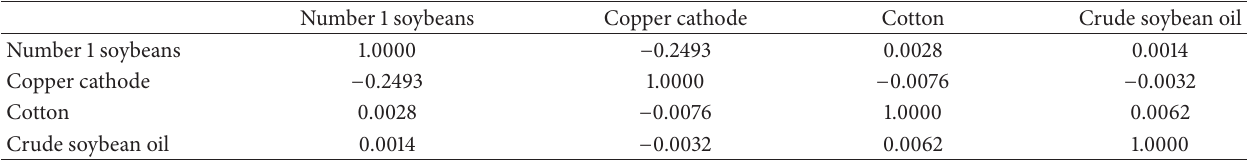
Table 4: Correlation coefficient matrix of futures